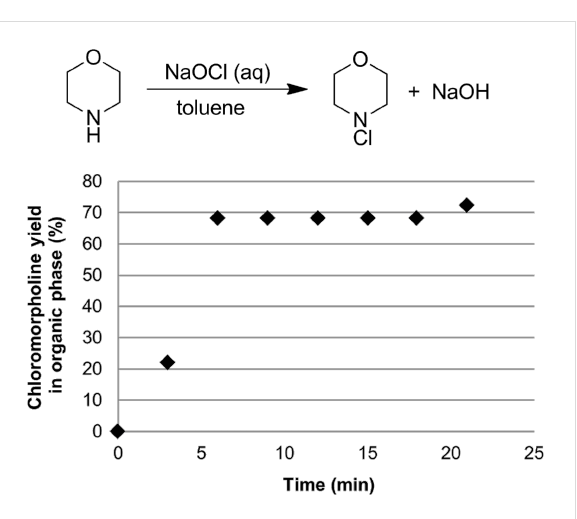
Figure 4: Progress of reaction for continuous formation of N -chloro- morpholine. Morpholine (toluene) 0.9 M 1 mL/min, NaOCl (aq) 0.9 M, 1.1 mL/min, 6 mL total reactor volume, of which 0.8 mL is static mixers. Residence time = 2.9 min. Conversion refers to composition of organic phase of reaction